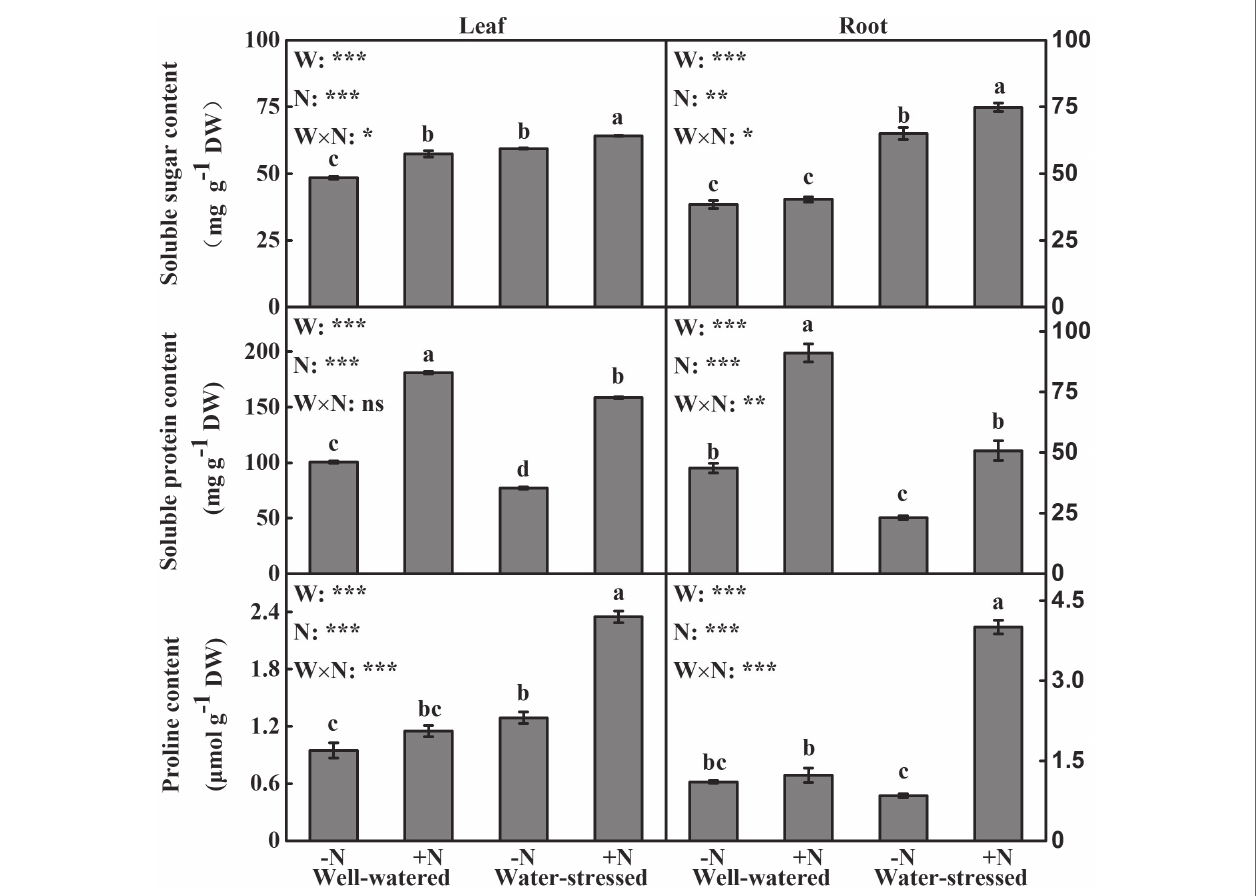
FIGURE 4 | Osmotic adjustment substances of Fargesia denudata leaves and roots for N non-deposition ( − N) and N deposition (+N) treatments with and without drought stress.